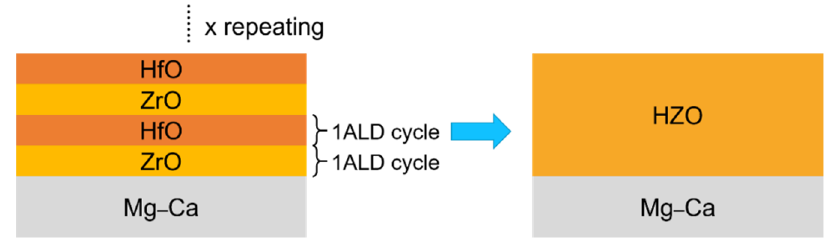
Figure 1. Schematic diagram of the growth process of ALD–HZO film. The HfZrO 2 film is deposited by one layer of ZrO followed by one layer of HfO. In this case, the ratio between Zr and Hf is 1:1.